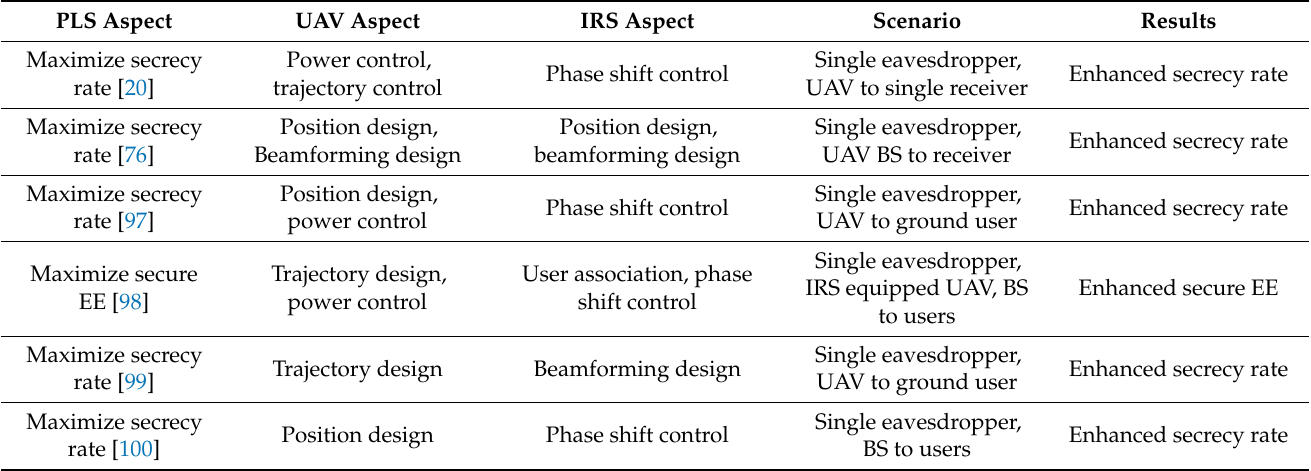
Figure 13. Secrecy capacity of IRS-assisted UAV system ( a ) impact of increasing transmit power at the UAV and ( b ) impact of increasing number of increasing elements of IRS [96]. Table 6. Existing works on IRS enabled PLS for UAV communication